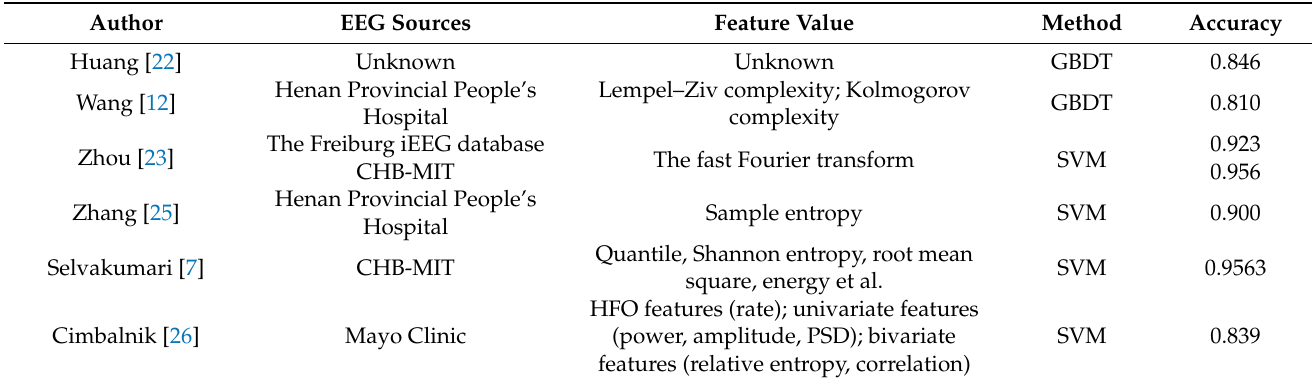
Table 3. Details of above